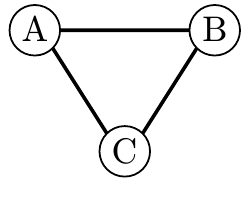
Figure 1. Full graph g N with N = { A , B , C } .